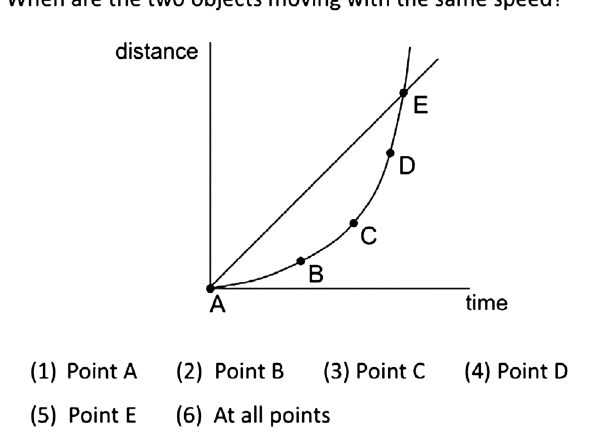
FIG. 9. Problem 7 used in studies 1 and 2.